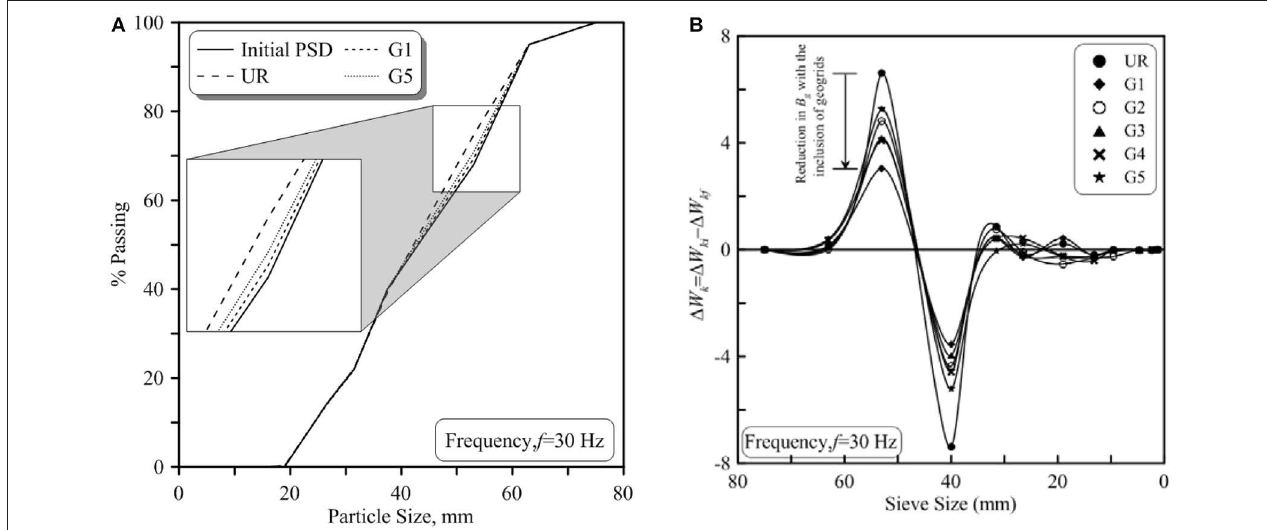
FIGURE 9 | (A) Change in PSD of ballast during cycling loading and (B) variation of particle distribution with sieve size for unreinforced and geogrid-reinforced